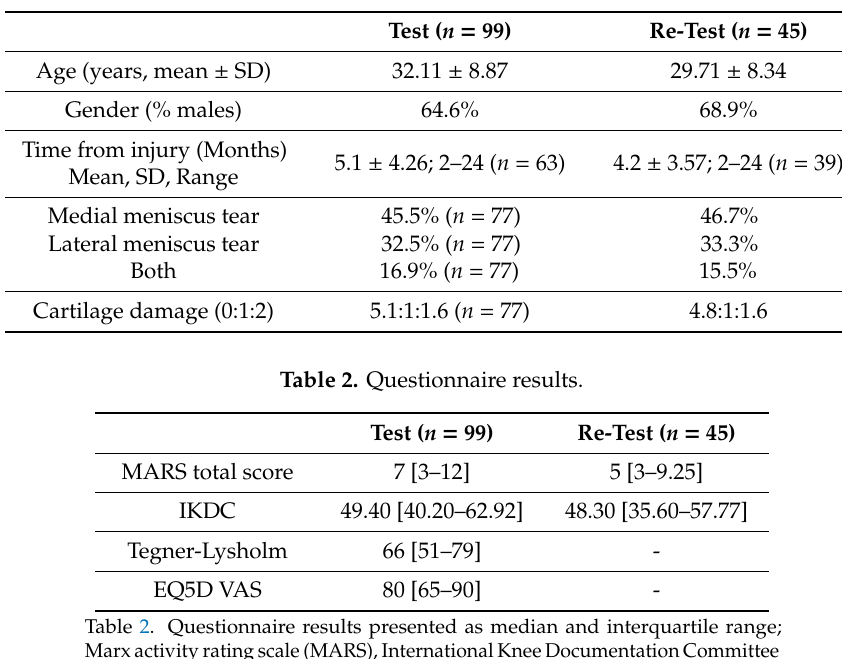
Table 1. Patient demographics and associated lesions.